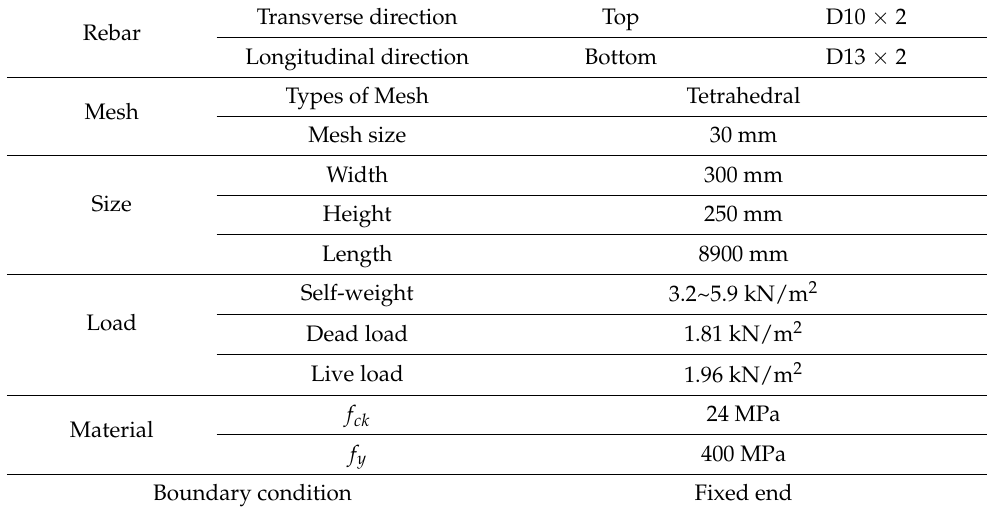
Table 3. Properties of the FE analysis model.